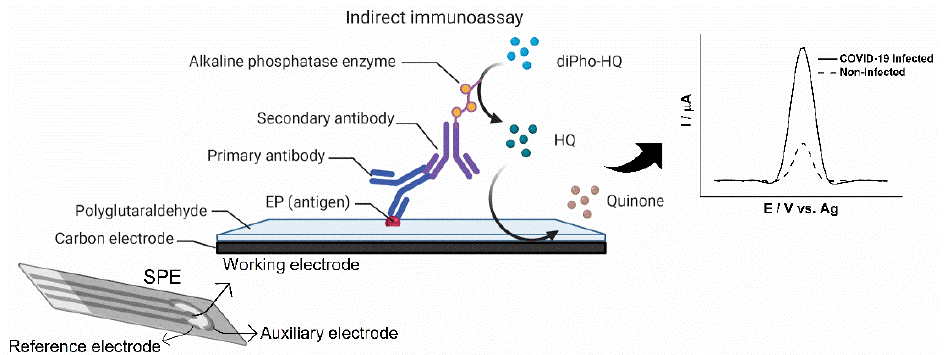
Figure 1. Schematic representation of a positive indirect immunoassay to detect COVID-19. Anti- SARS-CoV-2 IgG antibody (primary antibody) in patient serum samples is captured onto the surface of the SPE’s peptide-modified working electrode. Retained human antibodies are bound by AP- conjugated anti-human antibodies (Secondary antibodies). Enzymatic activity converts diPho-HQ into HQ, which can be measured by square-wave voltammetry.